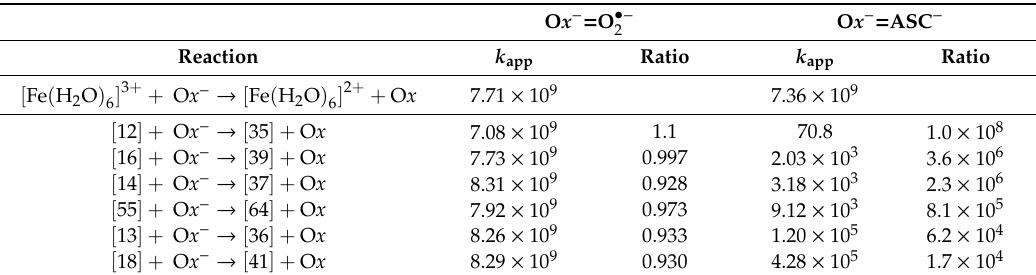
Table 5. Rate constants (in M − 1 s − 1 ) for the reduction of Fe(III) complexes (with and without DHLA 2 − ) •− − with O and with ascorbate (ASC ) in aqueous solution at 298.15 K and the rate constant ratios 2 ] 3 + as reference). a (using the reduction of [ Fe ( H 2 O ) 6